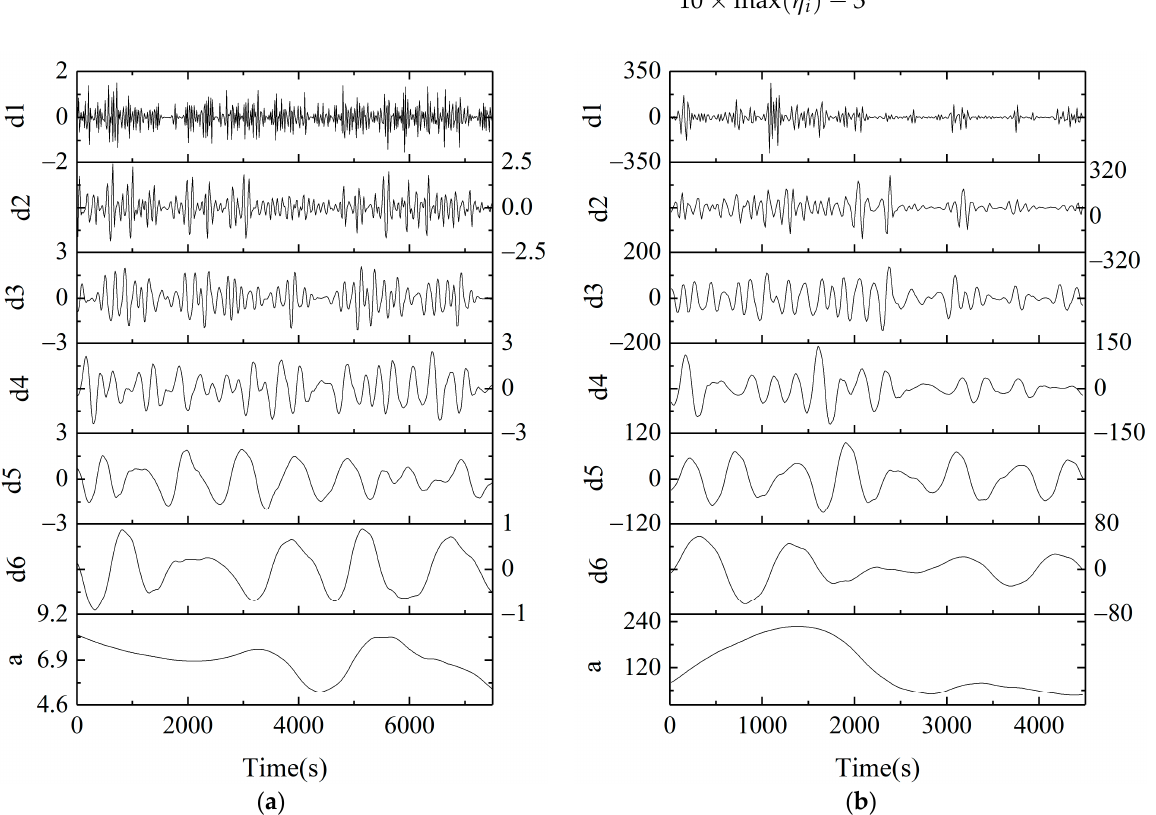
Figure 6. Decomposition signals. ( a ) EMR signal. ( b ) AE signal. Table 1. Similarity and critical value of the decomposed signals and the original signal.